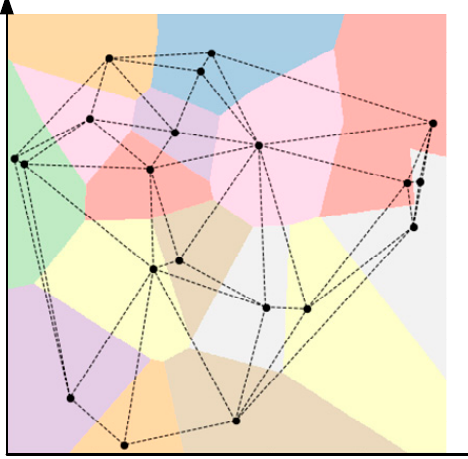
Figure 2. Example of Delaunay triangulation. The dashed line network is the Delaunay triangulation, and the colored polygon network is the Voronoi polygon.